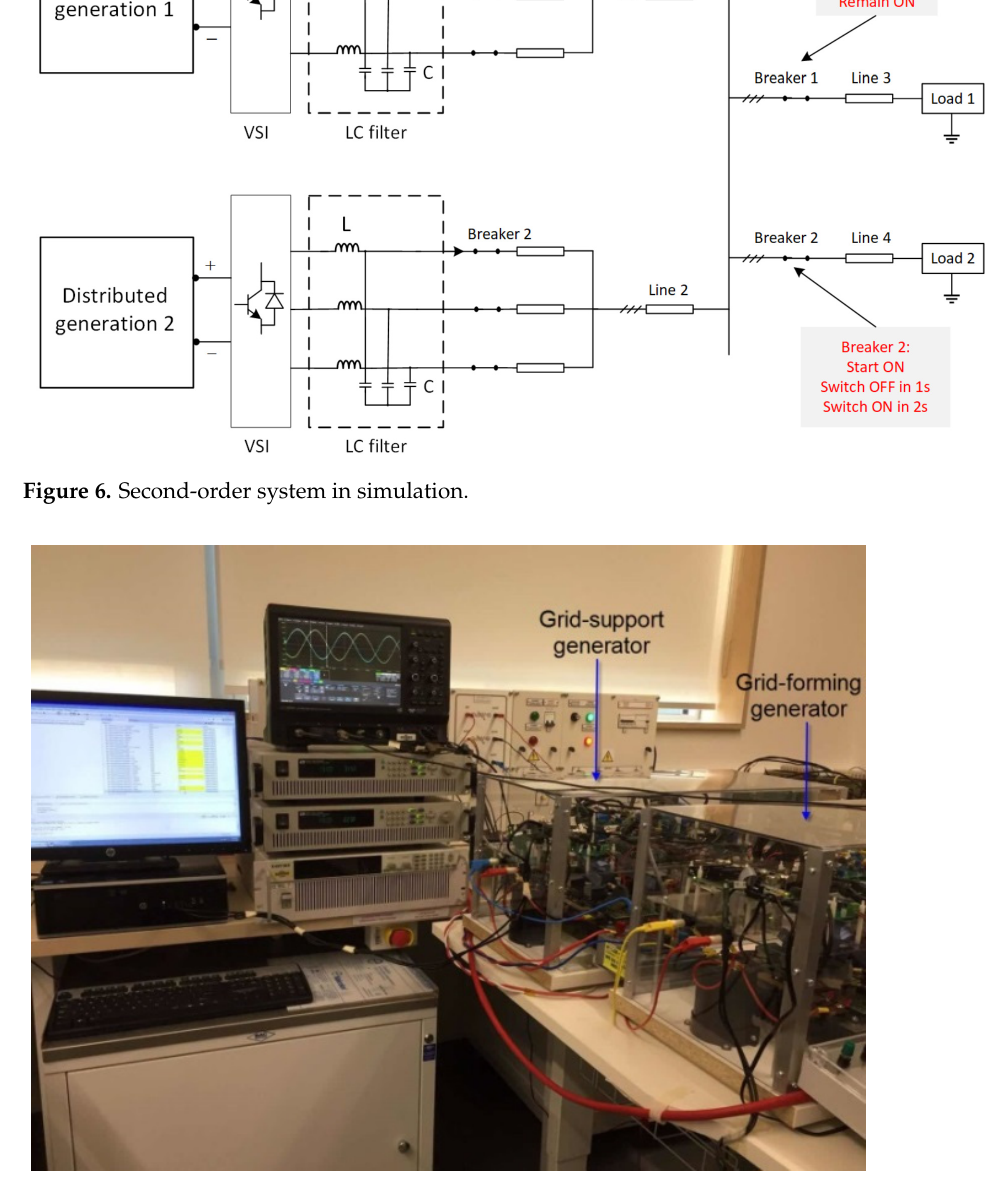
Figure 7. Experiment setup.